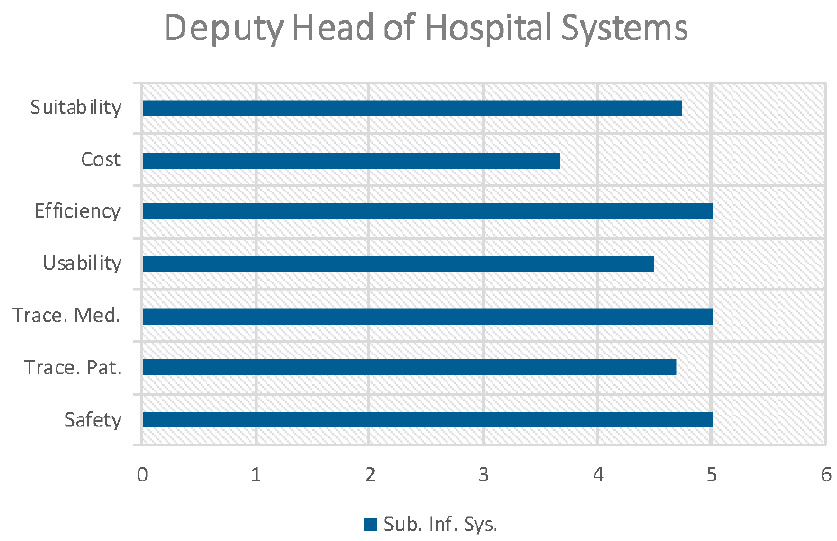
Figure 6. Values of the indicators as analysed for the Deputy Head of hospital systems.